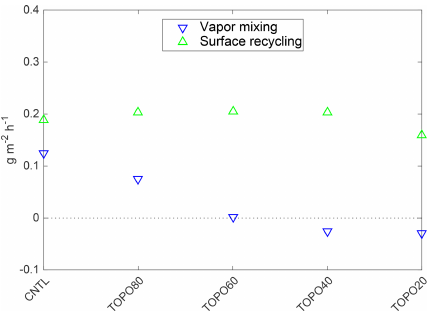
Figure 13. The mass flux of 18 O (gm − 2 h − 1 ) from summertime (June–July–August) vapor mixing and surface recycling on the Tibetan Plateau. Note that the positive (negative) values indicate sources (sinks) of 18 O. Surface recycling is the largest source of 18 O under all elevation scenarios. Vapor mixing is secondary as a source in high-elevation scenarios and becomes a sink in low-elevation sce-